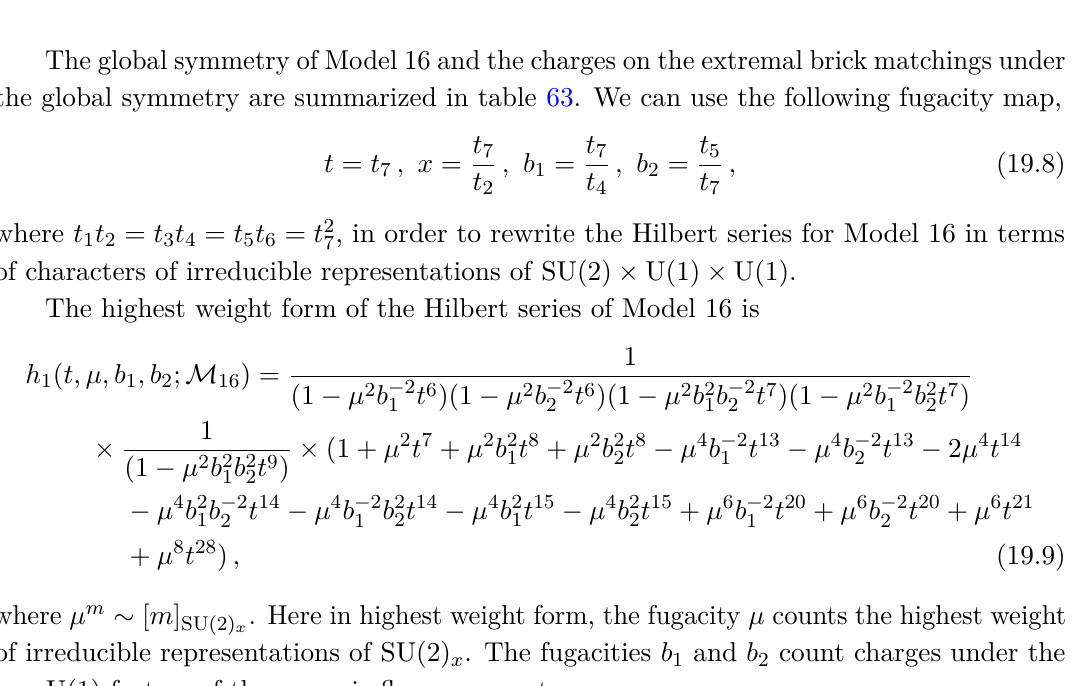
Table 63 . Global symmetry charges on the extremal brick matchings p i of Model